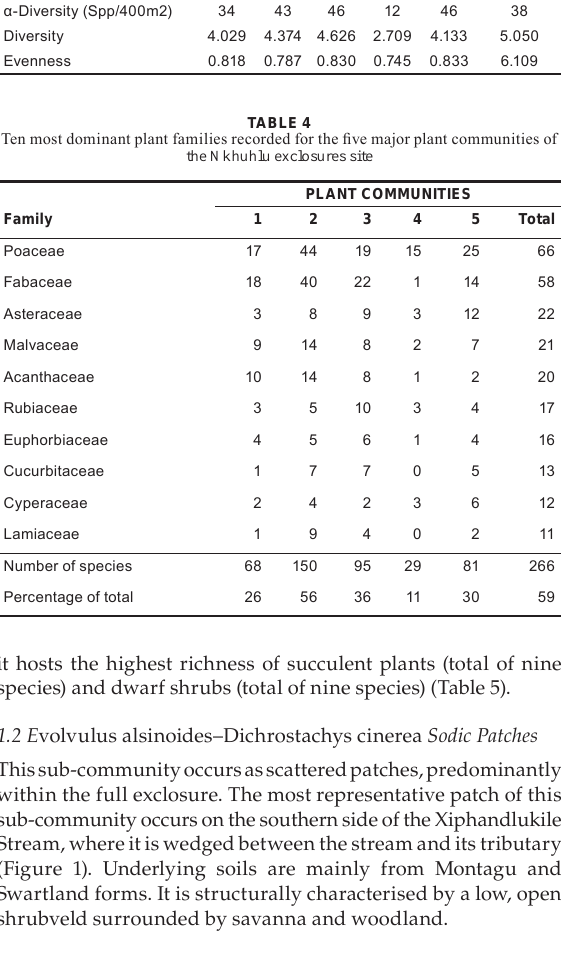
Table 3 site Plant communities